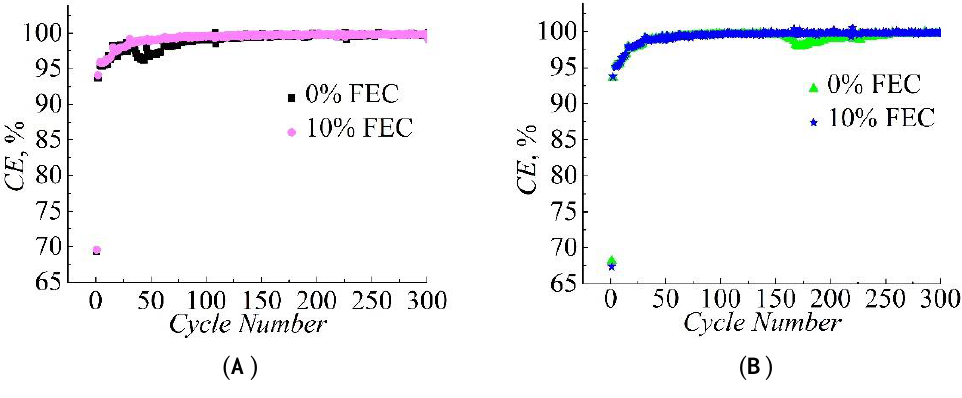
Figure 3. Columbic efficiency versus cycle number for samples in pairs ( A , B ).